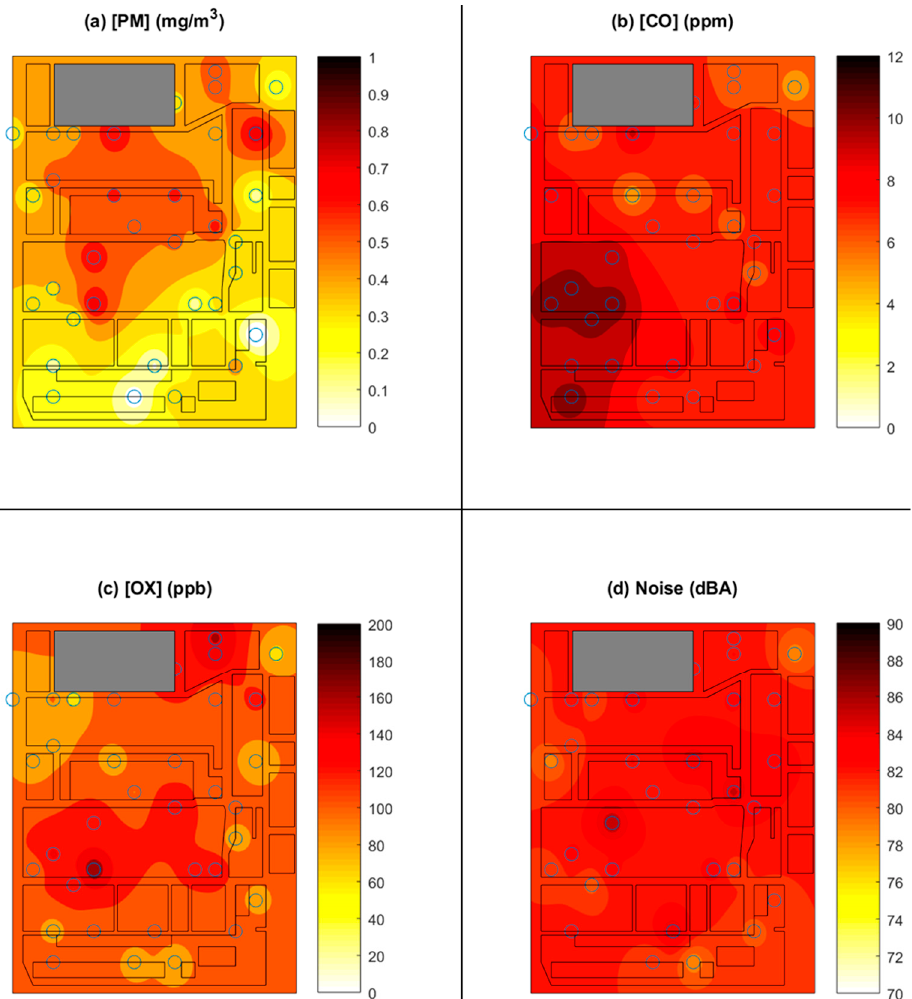
Figure 11. Hazard maps showing the average of ( a ) PM, ( b ) CO, ( c ) oxidizing gases, and ( d ) noise between 8:00 a.m. and 8:55 a.m. on a typical production day. Circles represent the location of the monitors in the factory. An inverse distance weighting scheme was used to estimate hazard levels between monitor locations. The lines indicate work areas in the factory that are generally divided by aisles. The gray-shaded area indicates the office area which is isolated from the manufacturing floor and was not part of the study area. The hue indicates the intensity of the hazard level. The study area is approximately 290 m × 250 m (75,000 m 2 ).